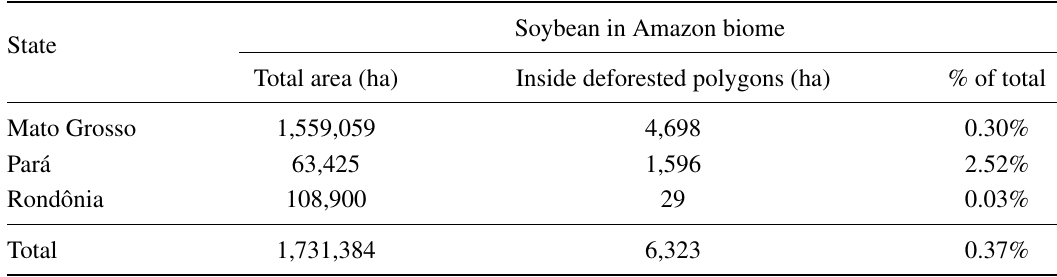
Table 7. Area in ha detected with soybean in the polygons of the Soy Moratorium compared with the total soybean area in ha within the Amazon biome, by